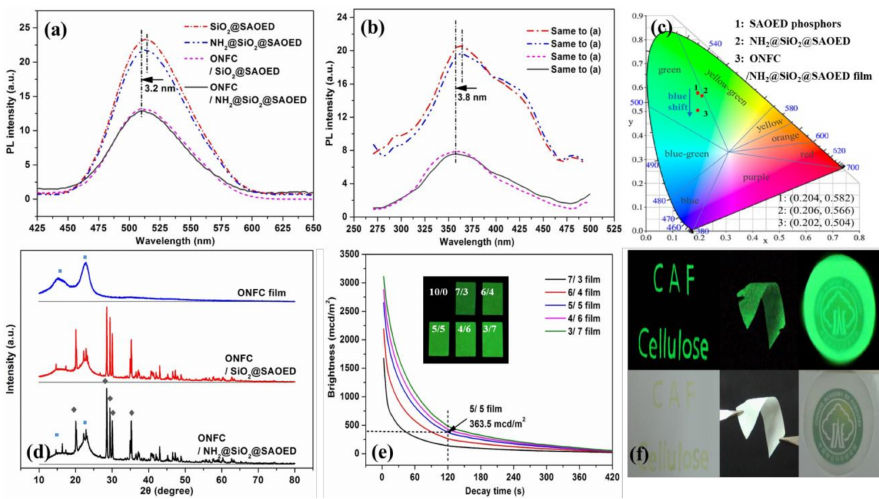
Figure 5. Photoluminescent (PL) performance for the SAOED phosphors and ONFC luminescent films: ( a ) emission and ( b ) excitation spectra of ONFC luminescent films with modified phosphors (ONFC/phosphor = 1/1); ( c ) CIE chromaticity diagram of SAOED phosphors before and after modification; and ONFC luminescent films with NH 2 @SiO 2 @SAOED phosphors in 1/1 mass ratio; ( d ) X-ray diffraction patterns for ONFC film, ONFC luminescent film with SiO 2 @SAOED and NH 2 @SiO 2 @SAOED phosphors (mass ratio = 1/1); ( e ) Decay curve of films with NH 2 @SiO 2 @SAOED in different mass ratios (inset: digital pictures of films in 2 min under dark); ( f ) Some potential examples of luminescent logo or flexible labels in darkness (first row) and daylight (second